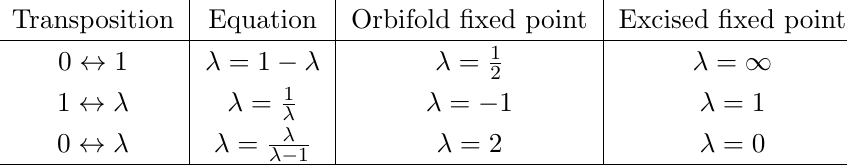
Table 2 . For each transposition in S 3 , we give the (cid:12)xed point equation and its two